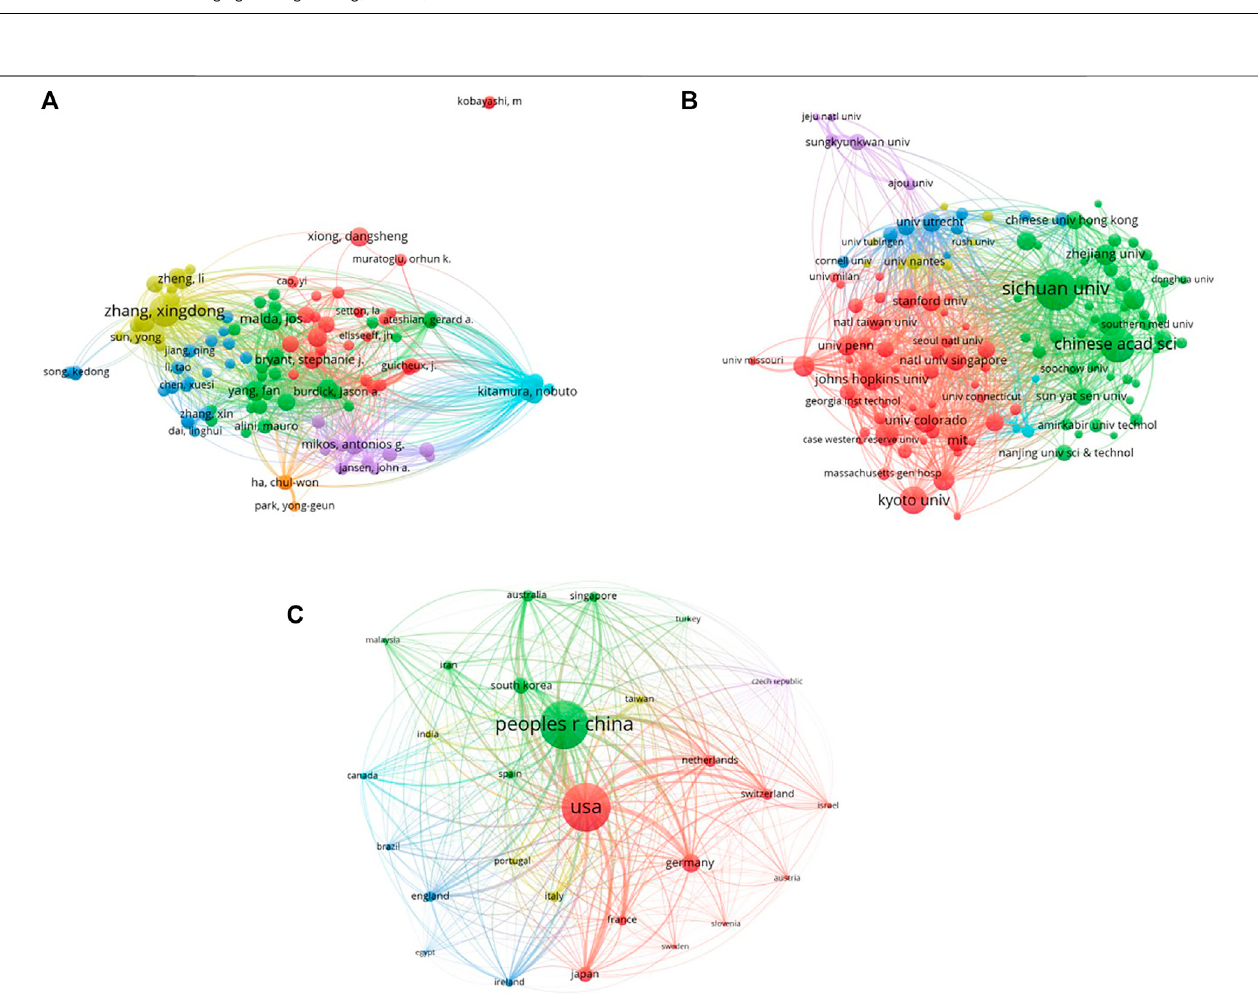
Figure6| Bibliographiccouplinganalysisofresearchonhydrogelsincartilagerepair. (A) Mapof113authorsrelatedtoresearchonhydrogelsincartilagerepair. (B) Map of 123 institutions related to research on hydrogels in cartilage repair. (C) Map of 29 countries related to research on hydrogels in cartilage repair. The thicker the connecting line the stronger the relationship between two